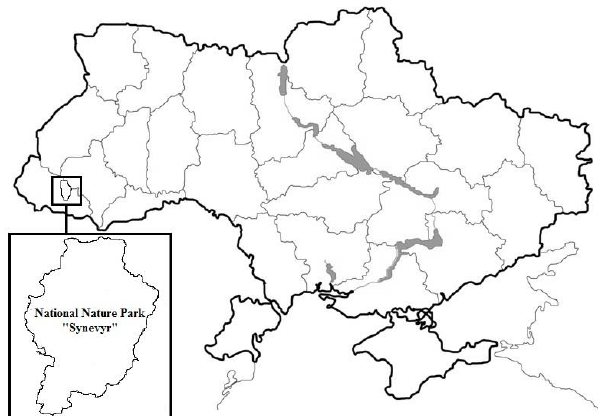
Fig. 1. The location of Synevyr National Nature Park within